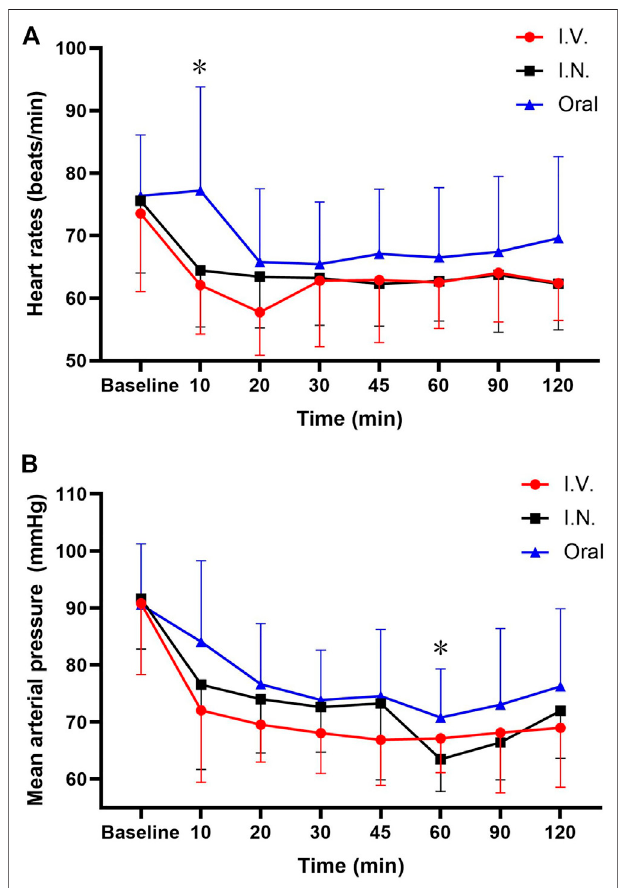
FIGURE 4 | Analysis of HR and MAP after DEX administration. DEX administration decreased HR and MAP. The average HR and MAP were higher in group of oral administration at all eight time points. HR was signi fi cantly reduced after 10 min in the IV group compared with the IN and oral groups. MAP decreased remarkably after 60 min in the IN group comparedtotheIVandoralgroups.* p < 0.05.DEX=dexmedetomidine;I.V.= intravenous; I.N. = intranasal.